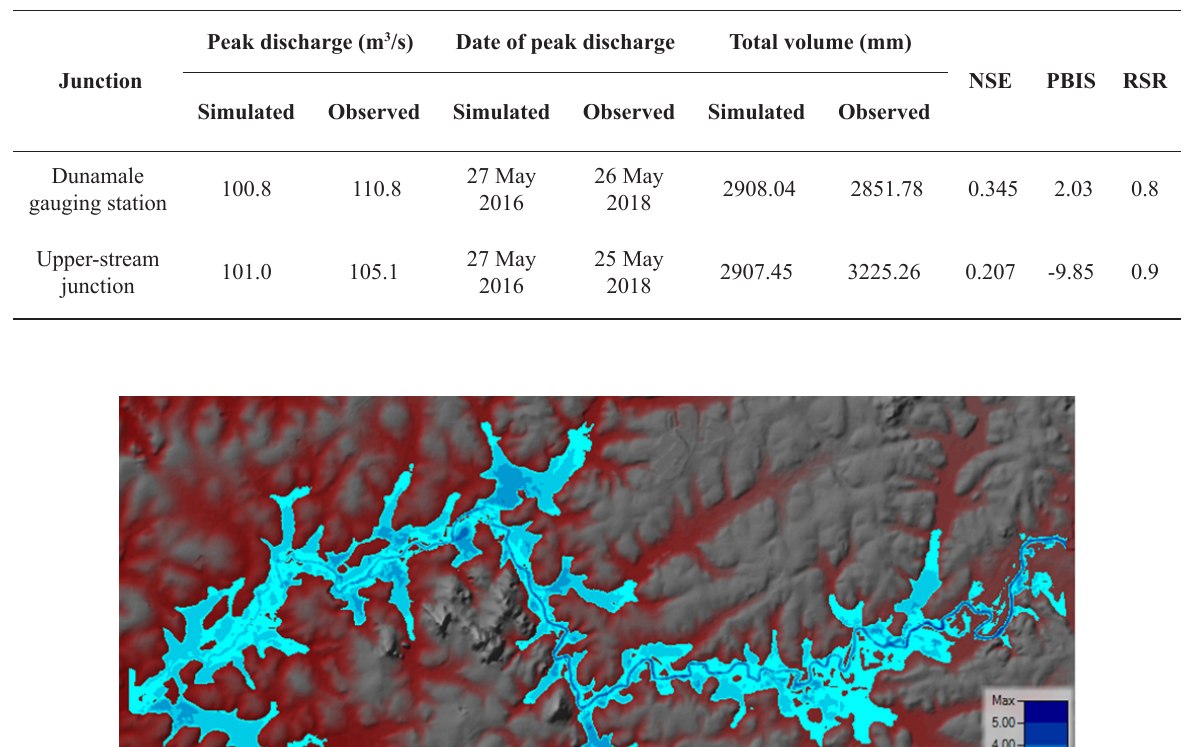
Table 4: Model performances statistics and summary of the performance of the HEC-HMS that used forecasted data.